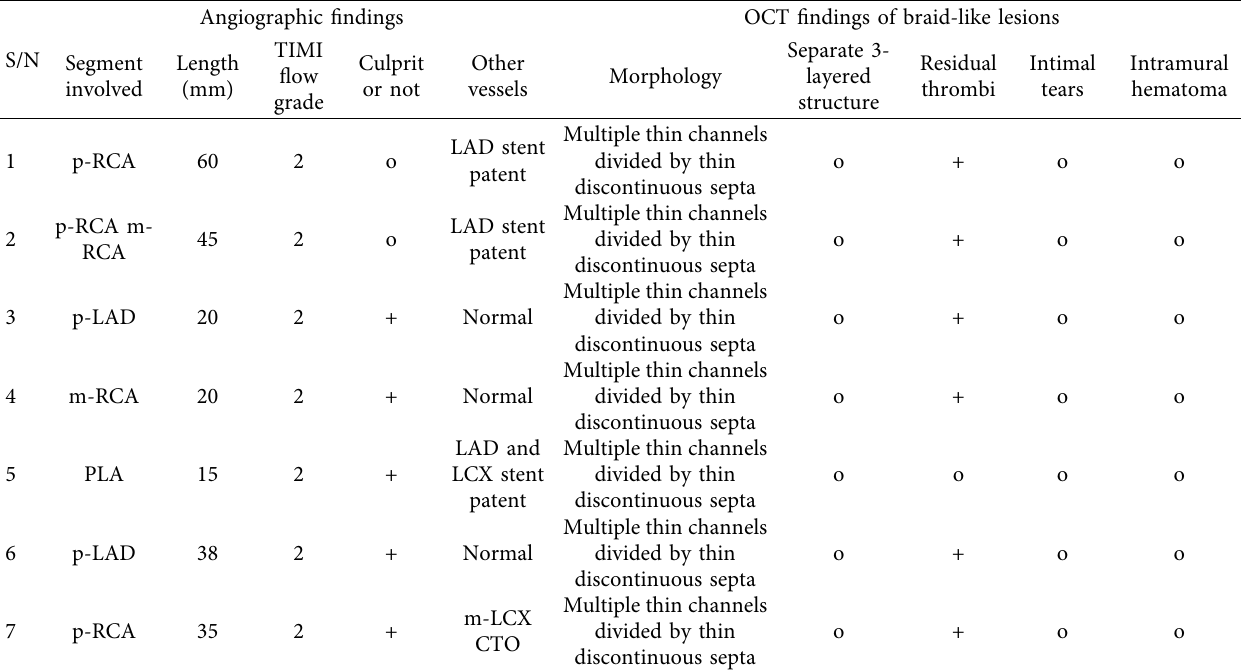
Table 3: Baseline angiographic and OCT